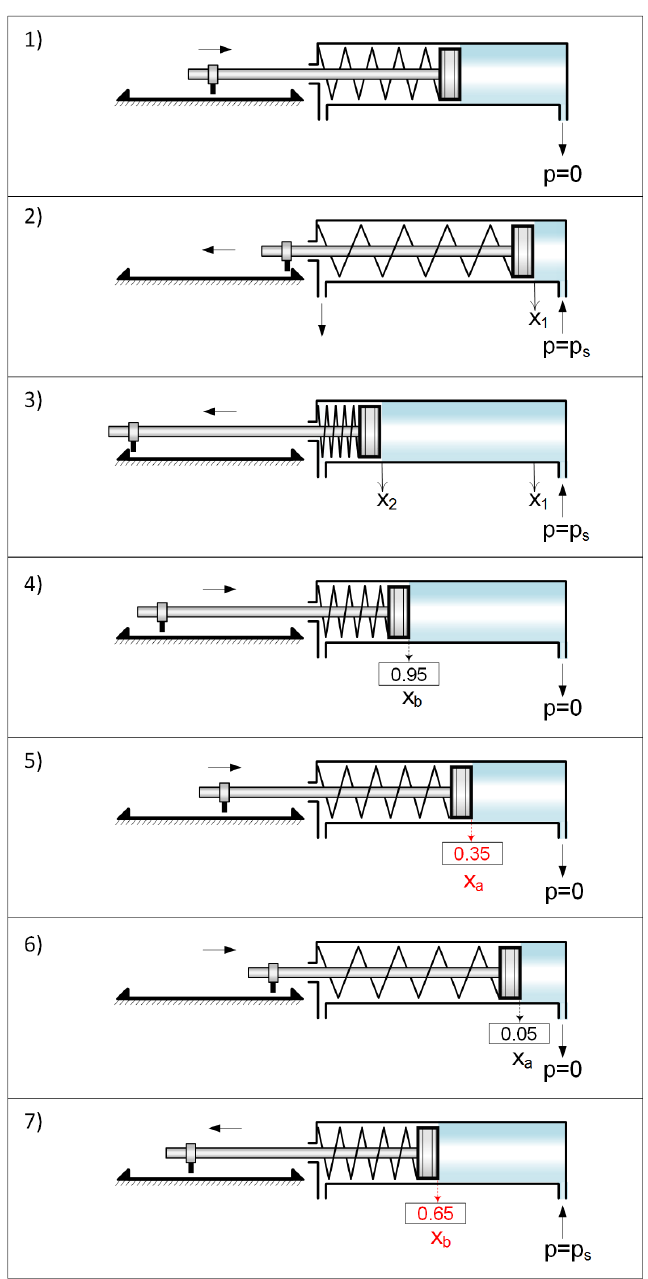
Figure 8. The sequence of the steps of the experimental part of the autotuner algorithm for single-action electro-pneumatic final control